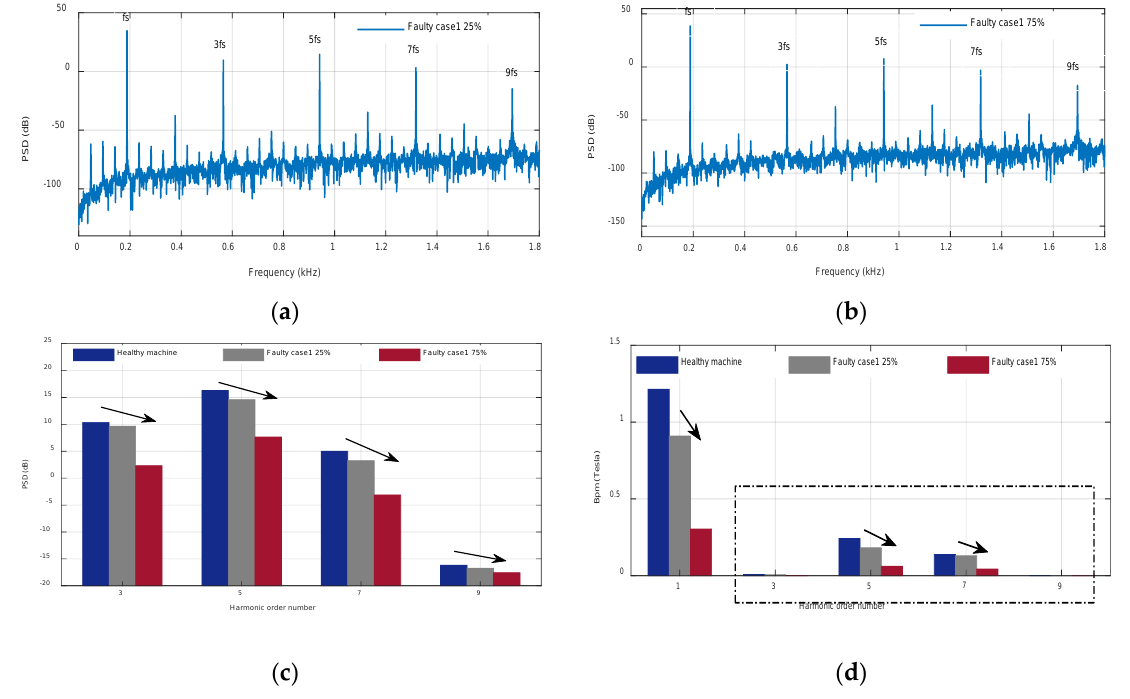
Figure 23. Faulty case 1: ( a ) PMSM current spectra normalized plot under 25%; ( b ) PMSM current spectra normalized plot under 75%; ( c ) amplitude of sideband components (ASBCs) harmonics variations; ( d ) airgap flux density distribution of harmonics magnitude variations.